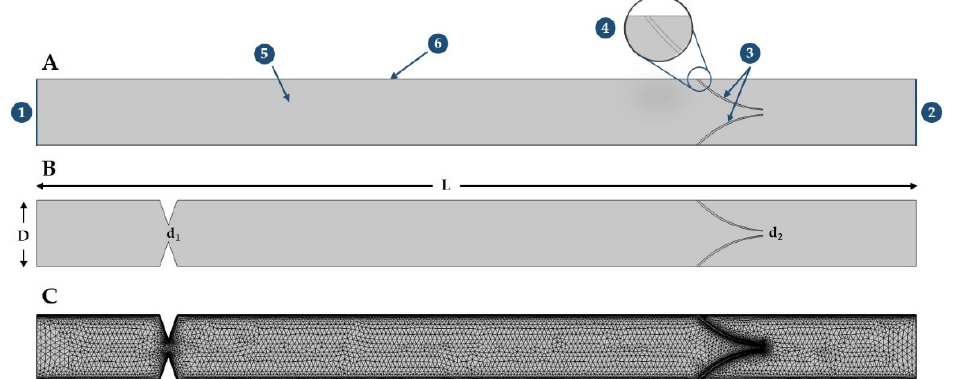
Figure 2. The scheme of the 2-dimensional model of the internal jugular vein and symmetrical 2-leaflets hyperelastic valve downstream; flow is from left to the right; this idealized model resembles real internal jugular vein with tandem stenosis from Figure 1. ( A ) without stenosis; ( B ) with 60% rigid stenosis at the beginning of this blood vessel (d 1 ) and flexible valve (d 2 ) downstream; and ( C ) free-triangular mesh with boundary layer.